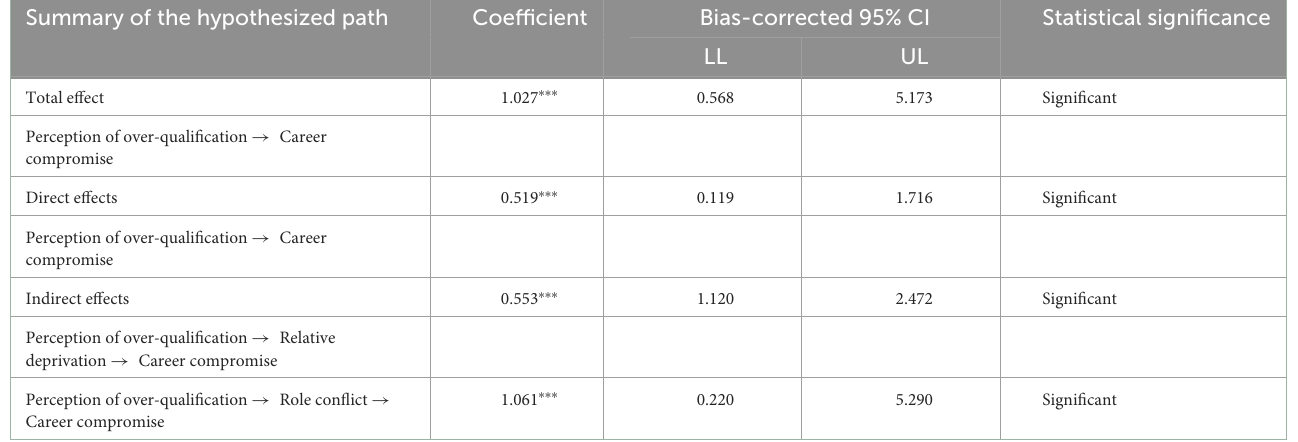
TABLE 6 Bootstrapping mediation effects